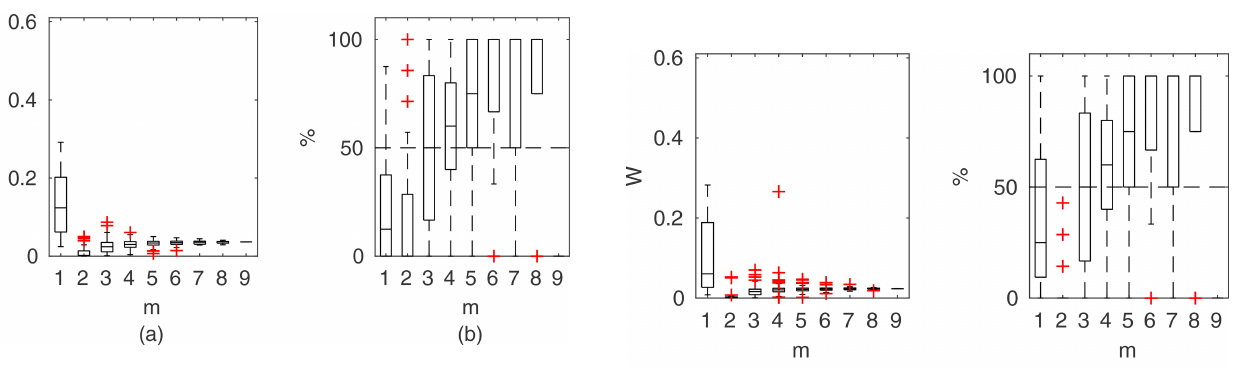
Figure B1. DCM Manning results for flume case 1: (a) aver- aged relative confidence widths W as a function of observation set size m used for model identification; (b) percentage of verifi- cation points enclosed by the confidence intervals (100% denotes all points within intervals, box spans over the 25% and 75% quan- tiles, the median is given with horizontal line, whiskers indicate the result extent, and cross marks are for extreme values).